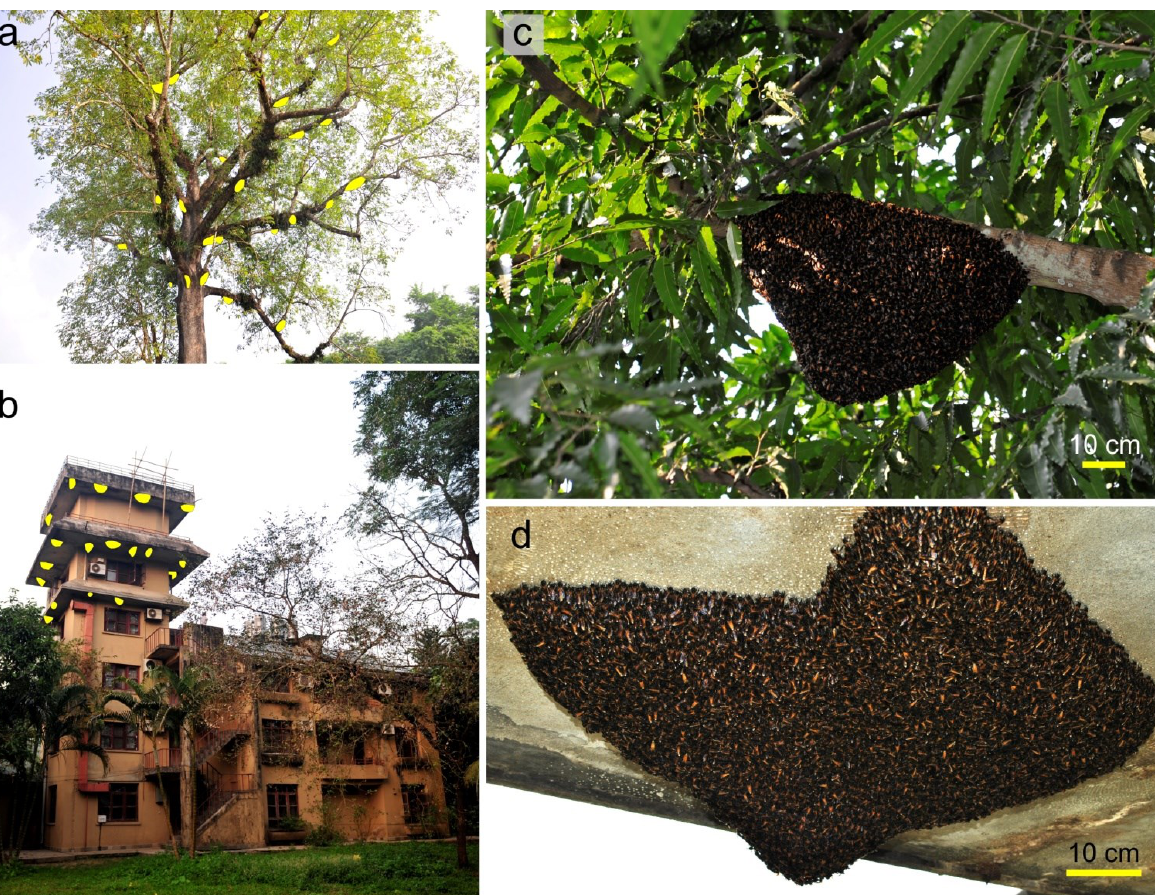
Figure 1. Typical giant honey bee nesting sites. Nests regularly occur on traditional sites where they form aggregations, ( a ) on a “bee tree” within the Chitwan National Park (Nepal) with 23 nests (marked in yellow); ( b ) nearby at a hotel with 18 nests; ( c , d ) two typically-sized, recently arrived giant honey bee swarms bivouacking on a limb of a tree ( c ), and near the final nesting site at the hotel ( d